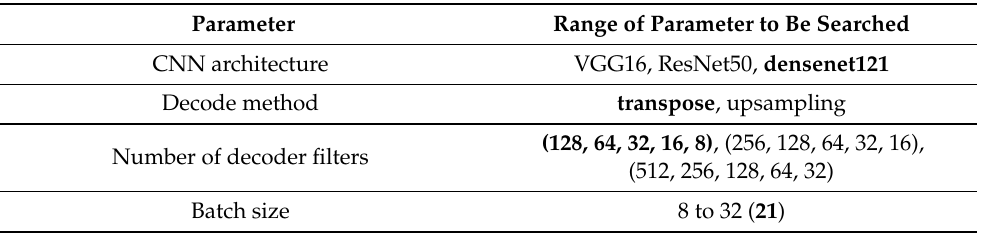
Table 2. The hyperparameter search and its results; the hyperparameters highlighted in bold were adopted. Parameter Range of Parameter to Be Searched CNN